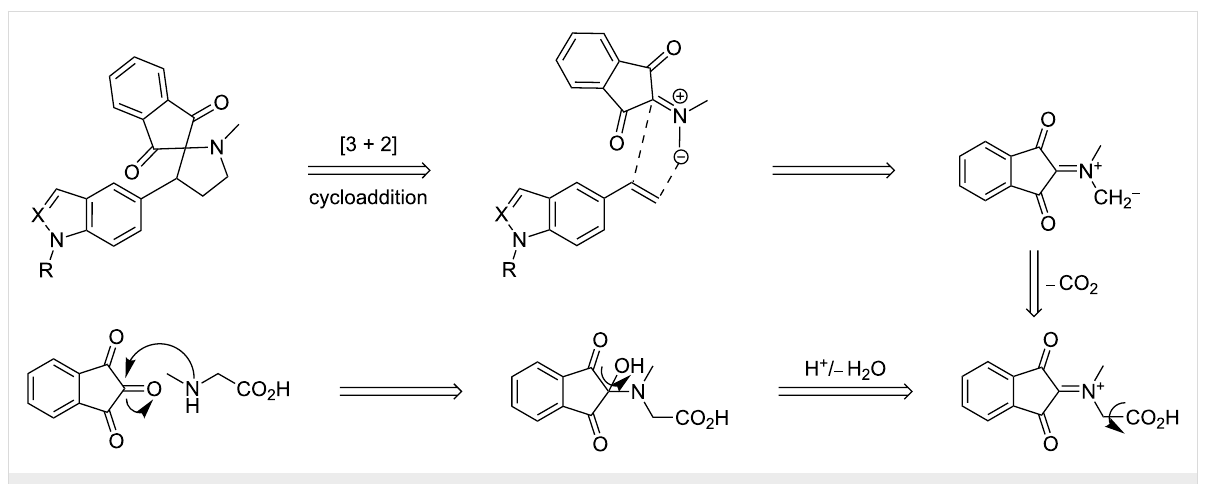
Scheme 2: Retrosynthetic strategy used for the synthesis of 7 and 8